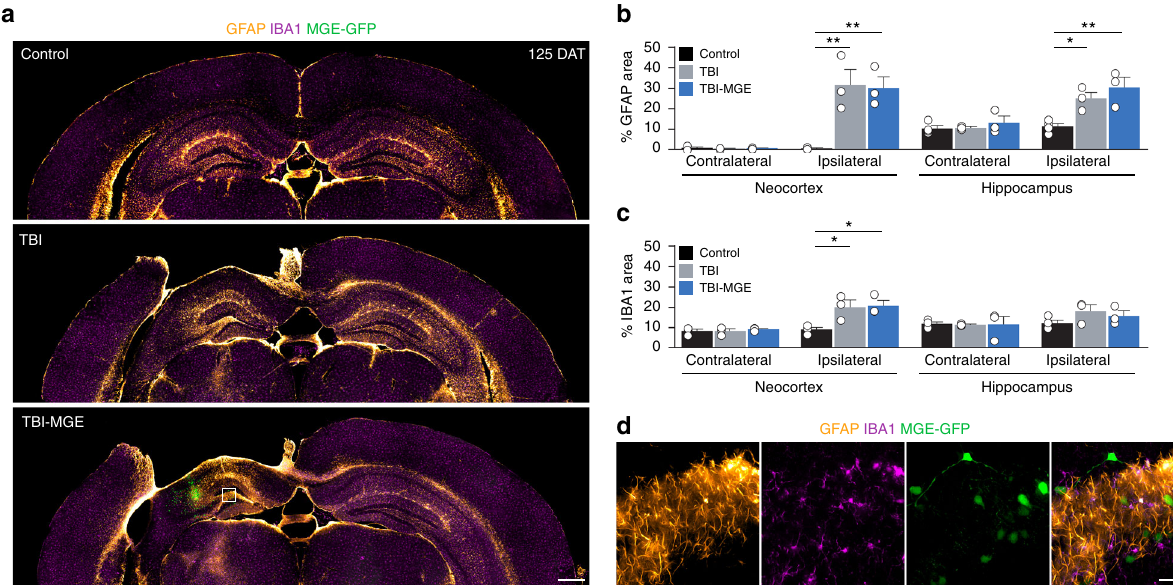
Fig. 4 MGE transplantation does not alter glial responses to TBI. a Coronal brain sections 125 DAT labeled for GFAP (orange), IBA1 (magenta) and transplanted MGE cells (green). In the ipsilateral hemisphere, there was prominent glial scar surrounding the impact site. b Quanti fi cation of GFAP expression in neocortex and hippocampus in sections contralateral and ipsilateral to the injury. Ipsilateral neocortex: ** P = 0.007, control vs TBI; ** P = 0.009, control vs TBI-MGE; one-way ANOVA with Bonferroni post hoc test; Ipsilateral hippocampus: * P = 0.04, control vs TBI; ** P = 0.008, control vs TBI- MGE; one-way ANOVA with Bonferroni post hoc test. n = 4 control mice, n = 3 TBI mice, n = 3 TBI-MGE mice. c Quanti fi cation of IBA1 immunostaining in neocortex and hippocampus in sections contralateral and ipsilateral to the injury. Ipsilateral neocortex: * P = 0.03, control vs TBI; * P = 0.03, control vs TBI- MGE; one-way ANOVA with Bonferroni post hoc test. d High resolution images of the boxed region in a labeled for GFAP (orange), IBA1 (magenta) and GFP (green). Transplanted MGE cells did not co-localize with glial markers ( n = 3 mice per marker). Error bars, s.e.m.; scale bars, 500 μ m ( a ) and 50 μ m ( d ). Source data are provided as a Source Data fi